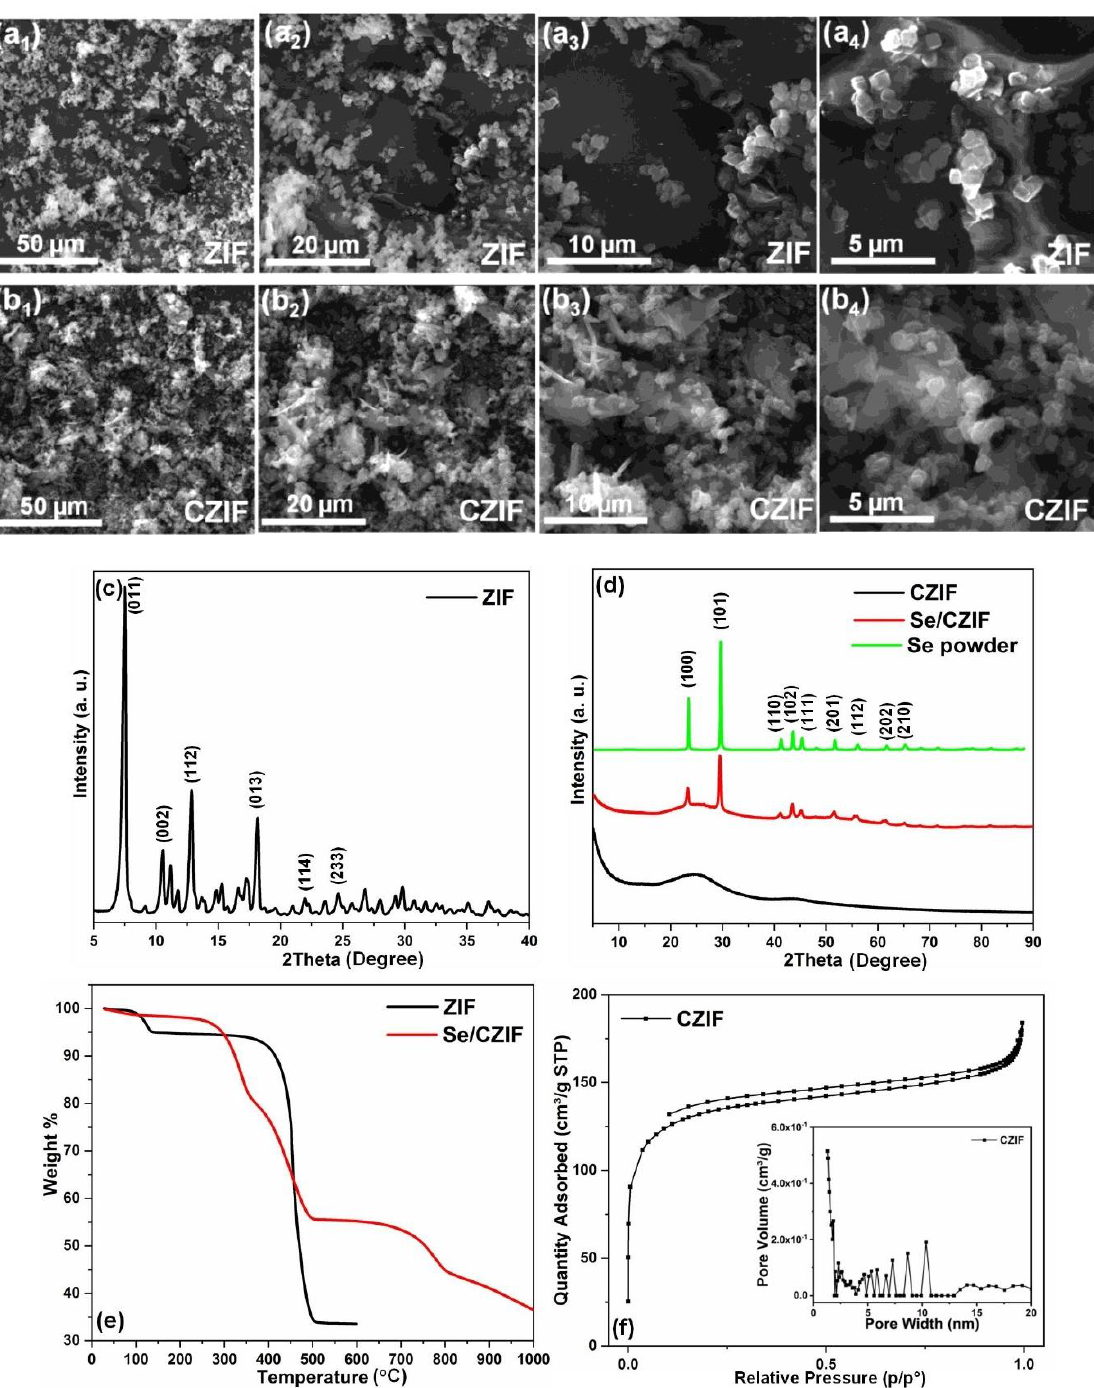
Figure 2. SEM images of ( a ) synthesized ZIF and ( b ) carbon derived from ZIF (CZIF) at different magnifications; XRD patterns of ( c ) synthesized ZIF and ( d ) CZIF, the Se/CZIF composite, and Se powder; ( e ) TGA spectrum of ZIF and Se/CZIF composite; and ( f ) N2 adsorption isotherm of CZIF (inset: pore size distribution of CZIF).